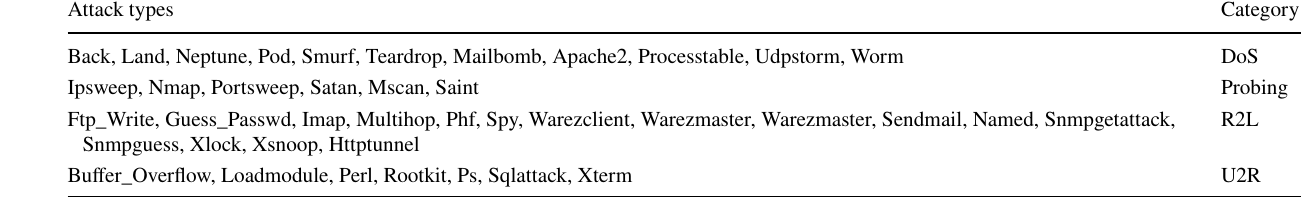
Table 6 Category of attack types